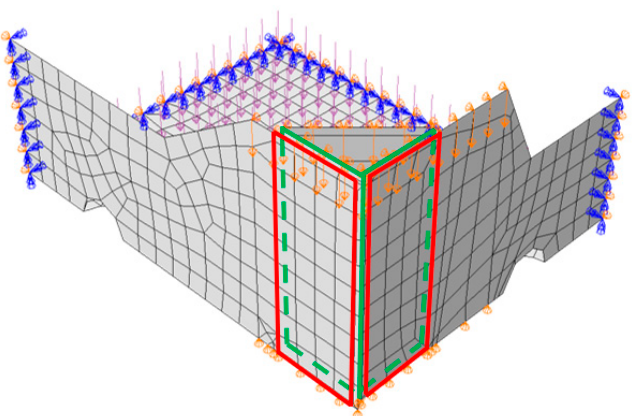
Figure 3. Finite element model of open-top cartons with boundary conditions and mesh (the red and green areas represent glued fragments of the panels).